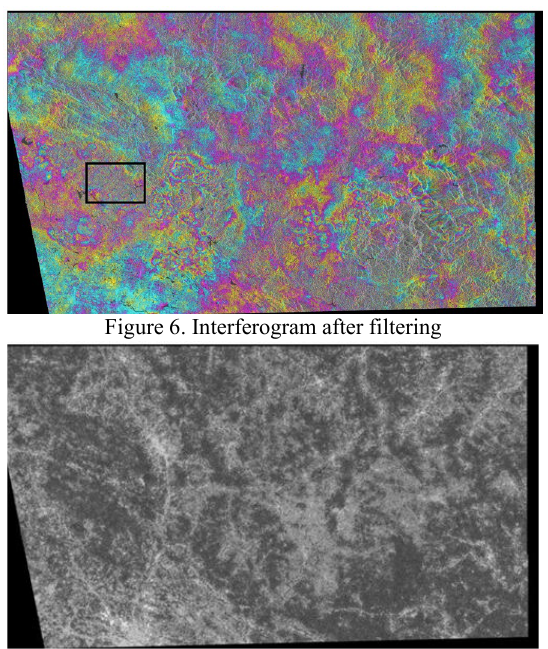
Figure 9 Result after